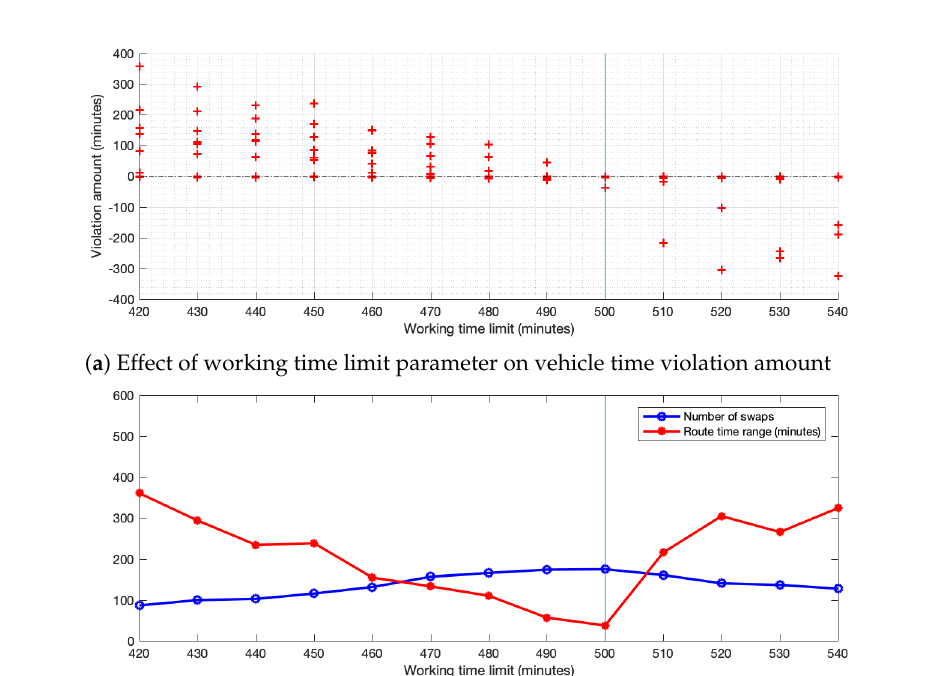
Figure 8. Analysis results of Problem B—12